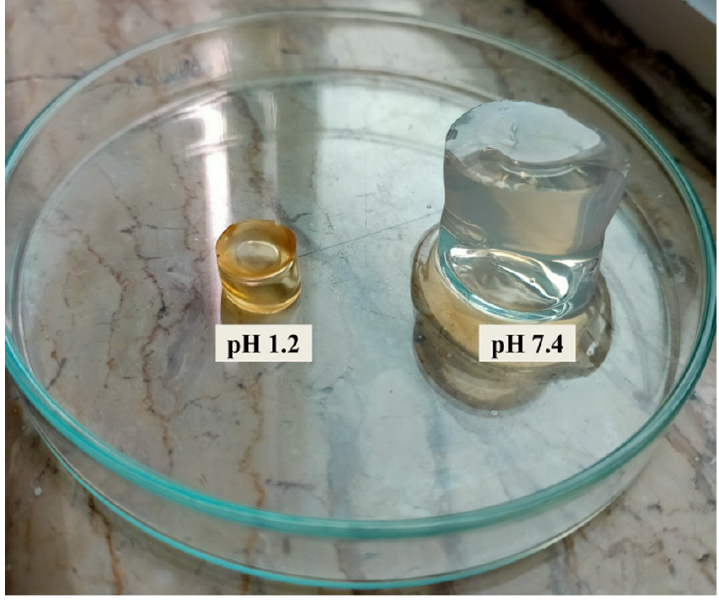
Figure 3. pH dependent swelling of HP β CD-grafted poly(MAA) hydrogels.